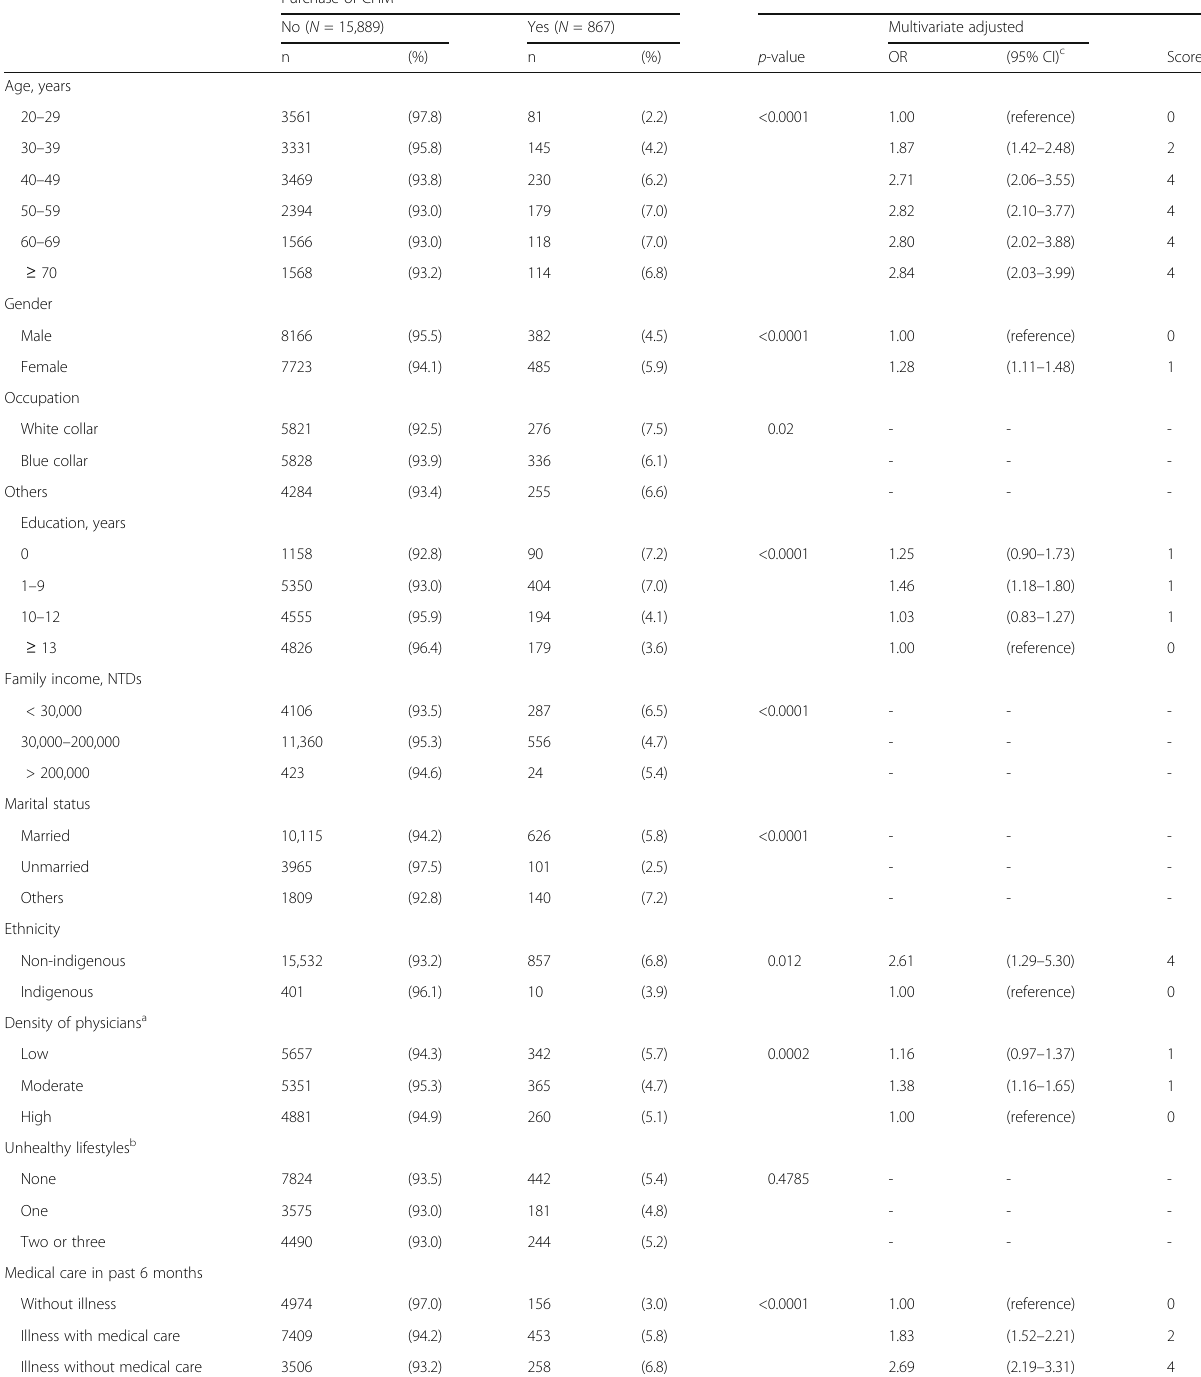
Table 1 Characteristics of people with and without purchasing CHM Purchase of